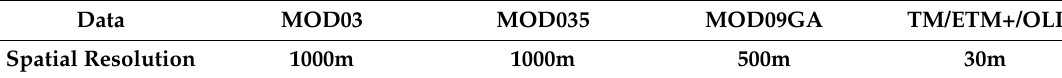
Table 1. The Landsat TM/ETM+/OLI and MODIS data used in this